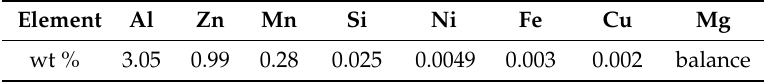
Table 1. Chemical compositions of AZ31B magnesium alloy (wt